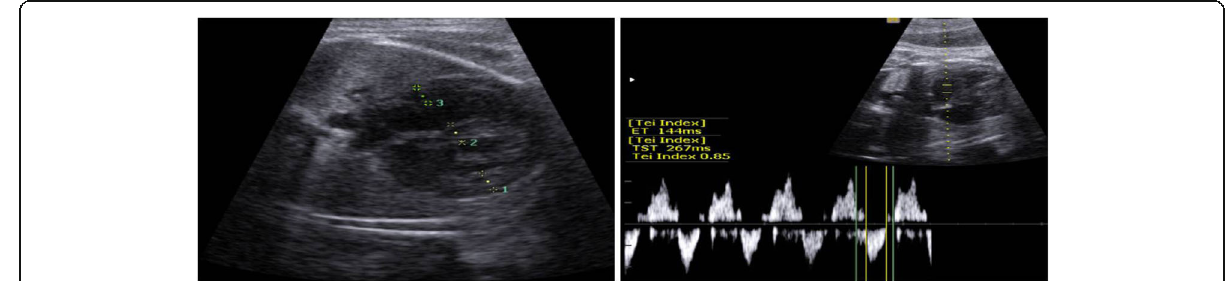
Fig. 7 2D measurement of myocardial and septal wall thickness in lateral 4 chamber view and Doppler derived measurement of left modified myocardial performance index in a pregnant female 32 years, with history of type II diabetes on regular oral hypoglycemic therapy came for routine antenatal ultrasound at 29 weeks gestation. AAbnormal increase in myocardial and septal wall thickness with abnormally high MPA above the reference values (RVWT = 0.68, LVWT = 0.65, IVST = 0.75, Tie =